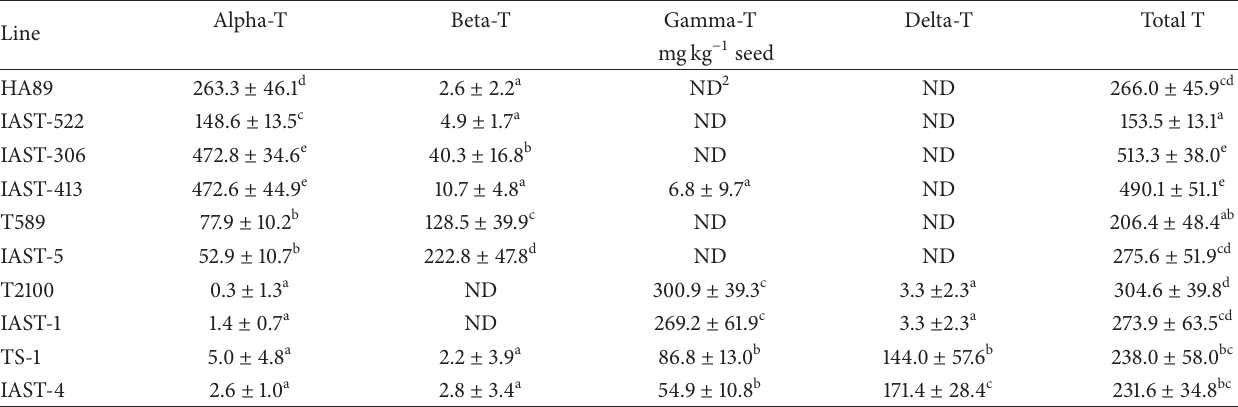
Table 1: 𝛼 -, 𝛽 -, 𝛾 -, 𝛿 -, and total tocopherol (T) content (mgkg −1 dry seed kernel given as mean ± SD) in nine sunflower lines with modified seed tocopherol levels and the control line HA89 1 .